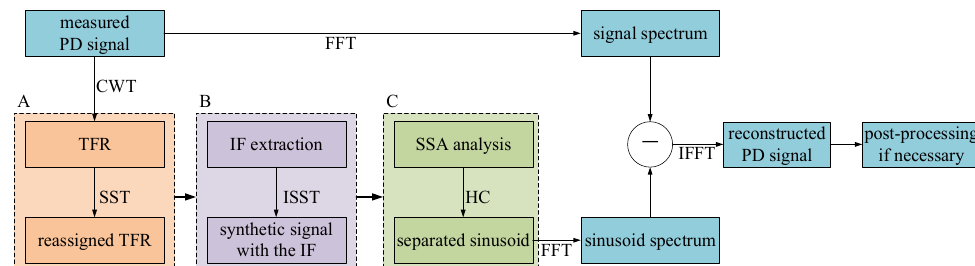
Figure 2. Flow chart of the proposed method.